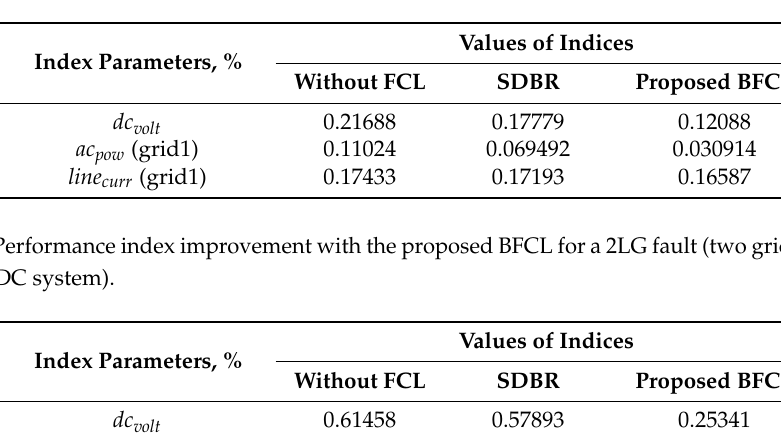
Table 5. Performance index improvement with the proposed BFCL for a 1LG fault (two grids-connected VSC-HVDC system).